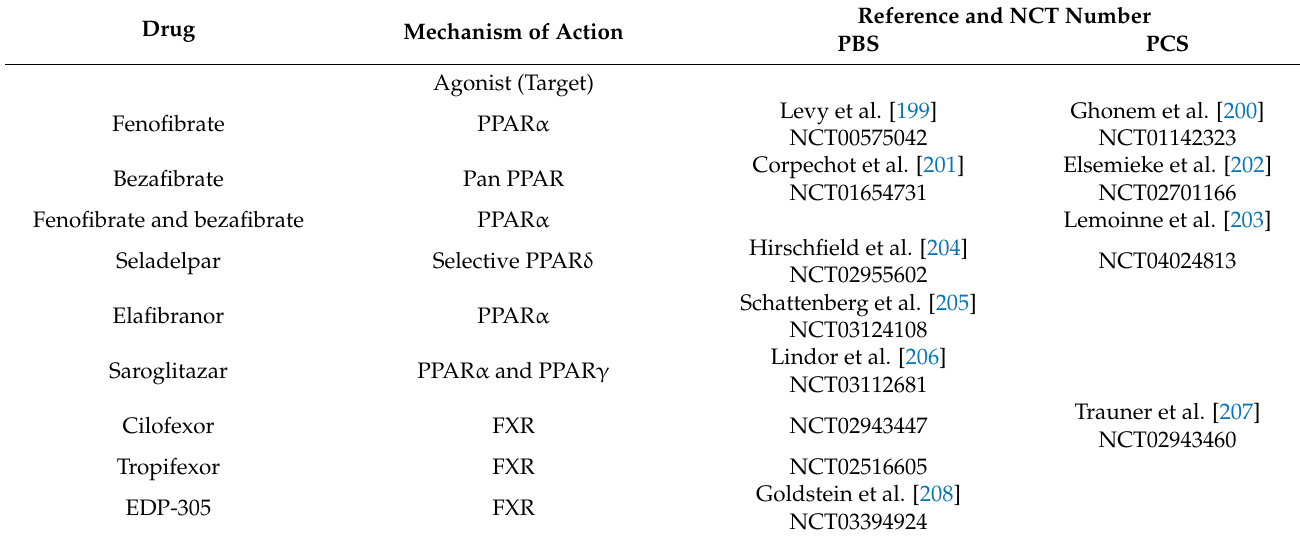
Table 2. Targets and drugs investigated for the treatment of PBS and